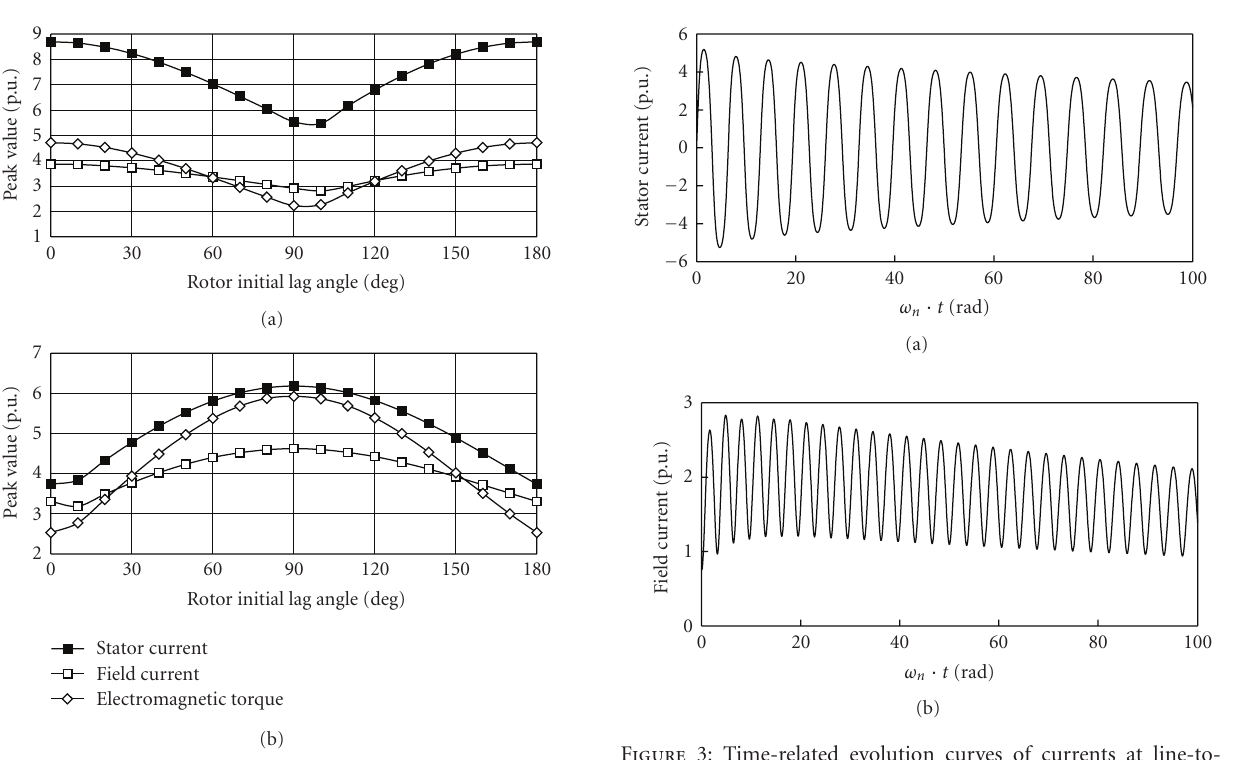
Figure 2: Dependencies of the peak values of short circuit characteristic quantities upon the initial value of rotor lag angle: (a) line-to-ground short circuit, (b) line-to-line short circuit.